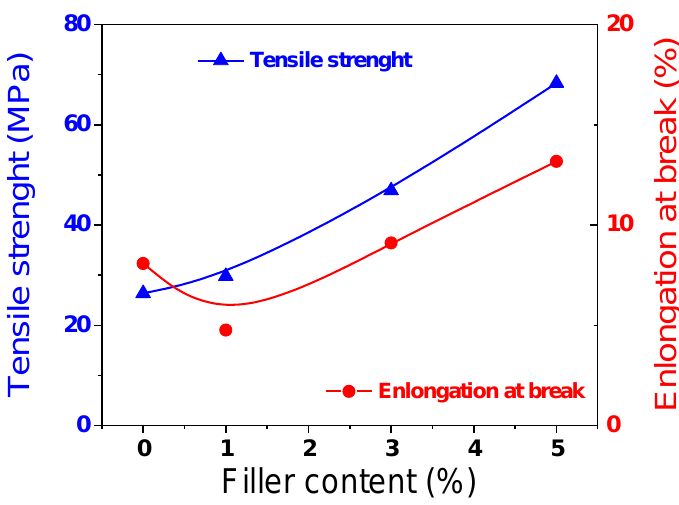
Figure 9. Tensile strength and elongation at break of S PEEK and nanocomposite membranes at 50 °C.